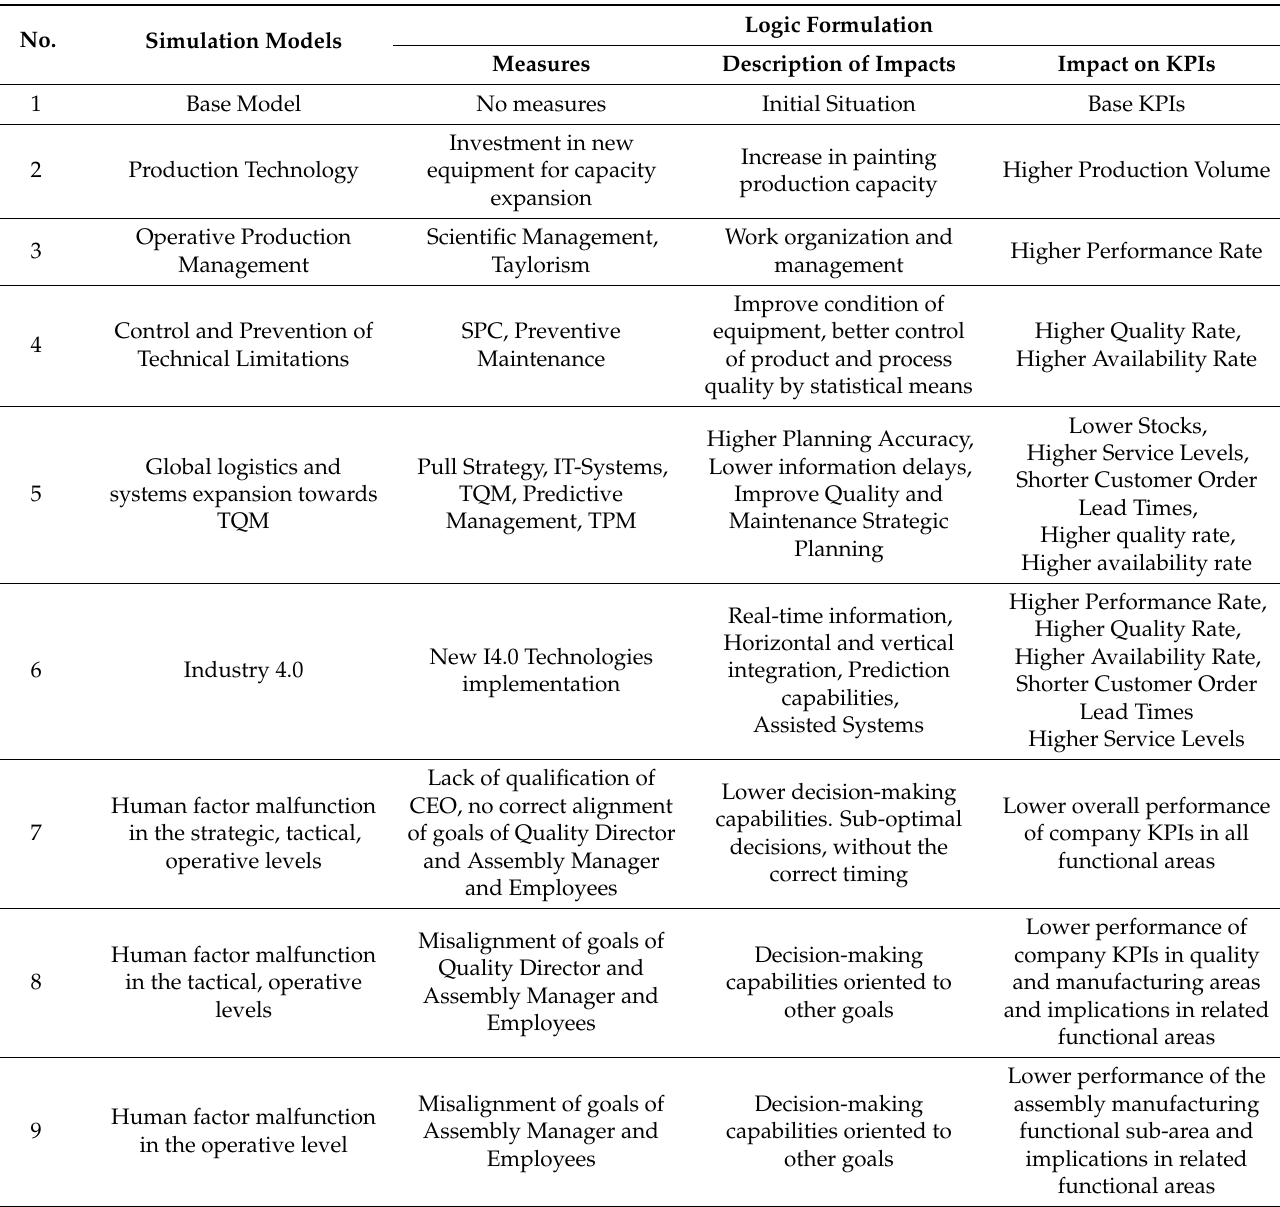
Table 1. Simulation models: logic